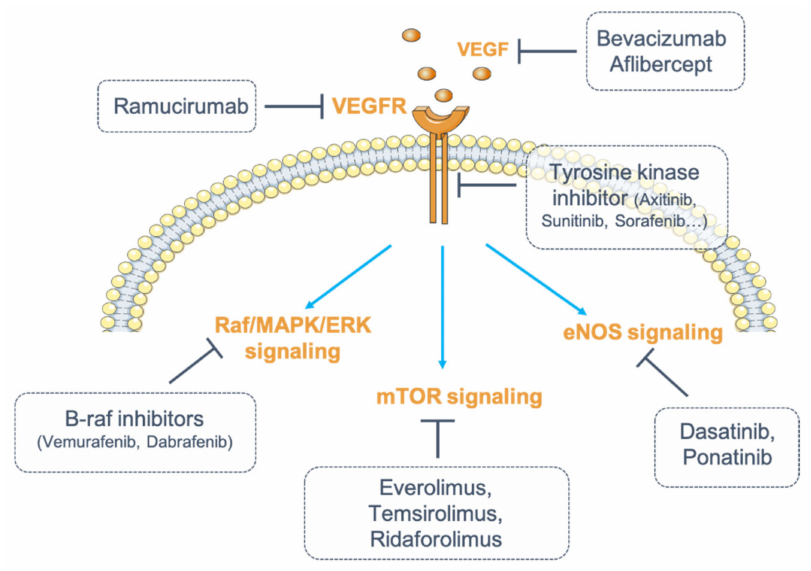
Figure 1. Inhibition of vascular endothelial growth factor (VEGF)/vascular endothelial growth factor receptor (VEGFR) signaling. Numerous strategies exist to inhibit VEGF/VEGFR signaling. VEGF can be blocked by monoclonal antibodies (mAbs) (bevacizumab) or by fusion proteins (aflibercept). Its receptor, VEGFR, can be targeted by fully humanized monoclonal antibodies (ramucirumab). The receptor can also be targeted for its intracellular tyrosine kinase activity (tyrosine kinase inhibitors, TKIs). Finally, one strategy consists of inhibiting the downstream signaling pathways of VEGFR by targeting either the Raf (Rapidly Accelerated Fibrosarcoma)/mitogen-activated protein kinase (MAPK)/ERK (Extracellular signal-Regulated Kinase) pathway with B-Raf inhibitors (dabrafenib, vemurafenib), or the endothelial nitric oxide synthase (eNOS) pathway (dasatinib, ponatinib) or the mammalian target of rapamycin (mTOR) pathway (everolimus, temsirolimus,